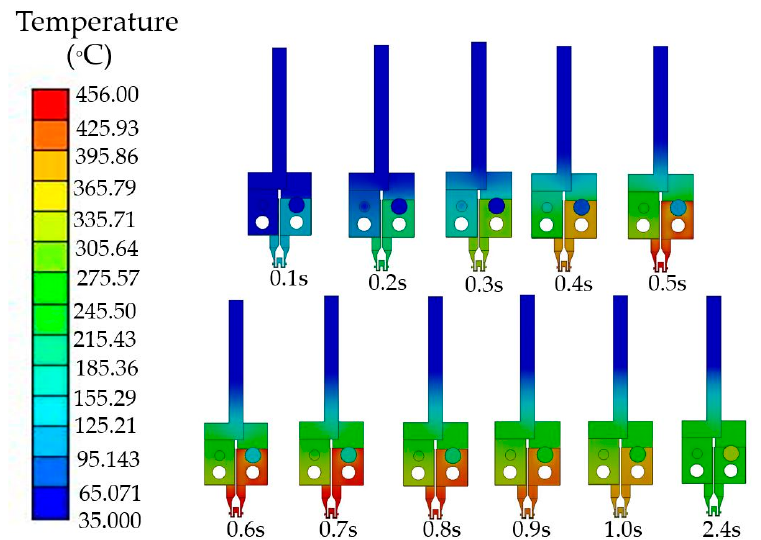
Figure 13. Heat transfer behavior and temperature of the series WT for 0.1 s–2.4 s.